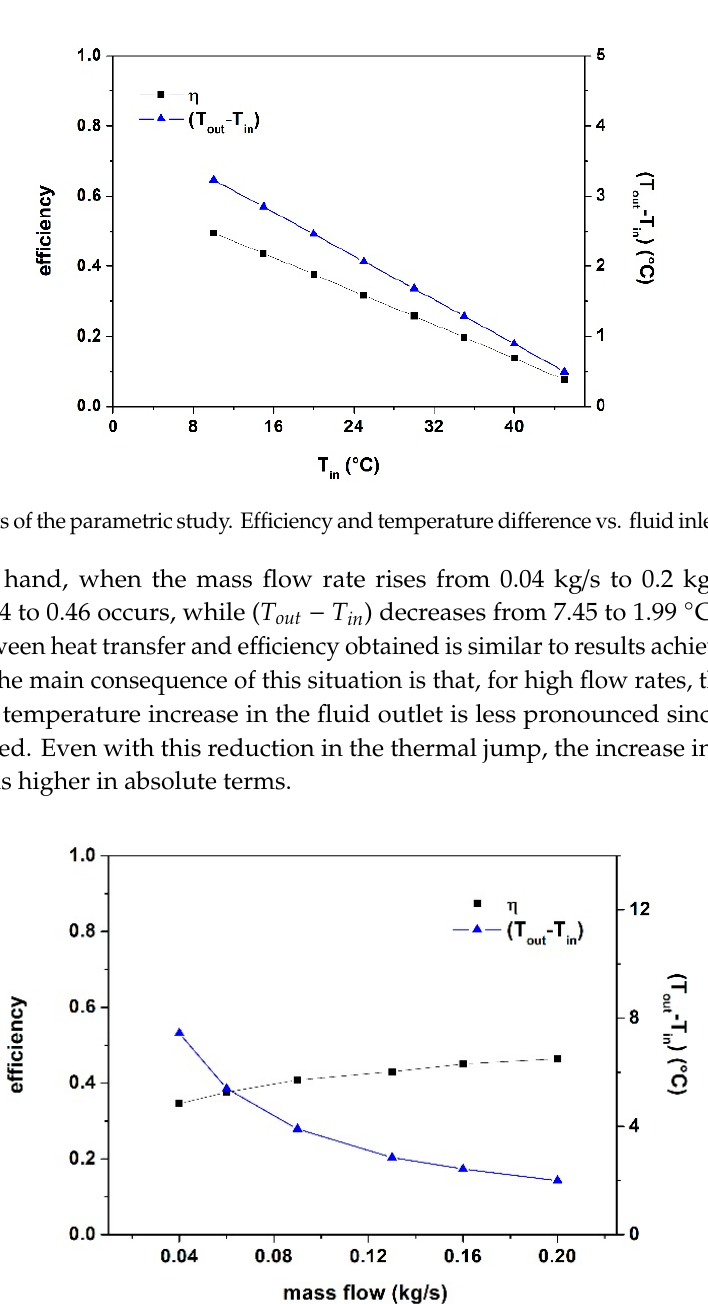
Figure 11. Results of the parametric study. Efficiency and temperature difference vs. ambient temperature. The solar irradiation apparently can be considered as one of the most influencing parameters because it is the main source providing energy to the collector. A significant effect can be appreciated for the case of temperature difference ( T out − T in ) [29] and consequently the increase of irradiation implies a higher energy output, but the impact is less significant on the efficiency. Even for big increases of irradiation (Figure 12) from 100 W/m 2 K to 1000 W/m 2 K, the efficiency barely changes from 0.40 to 0.43, while the ( T ou t − T in ) linearly rises up strongly from 0.44 to 4.71 °C. A ten times variation in the irradiance implies the same proportional variation in the thermal difference with a linear relation, but just a small variation of three percentual points is perceived in the efficiency.